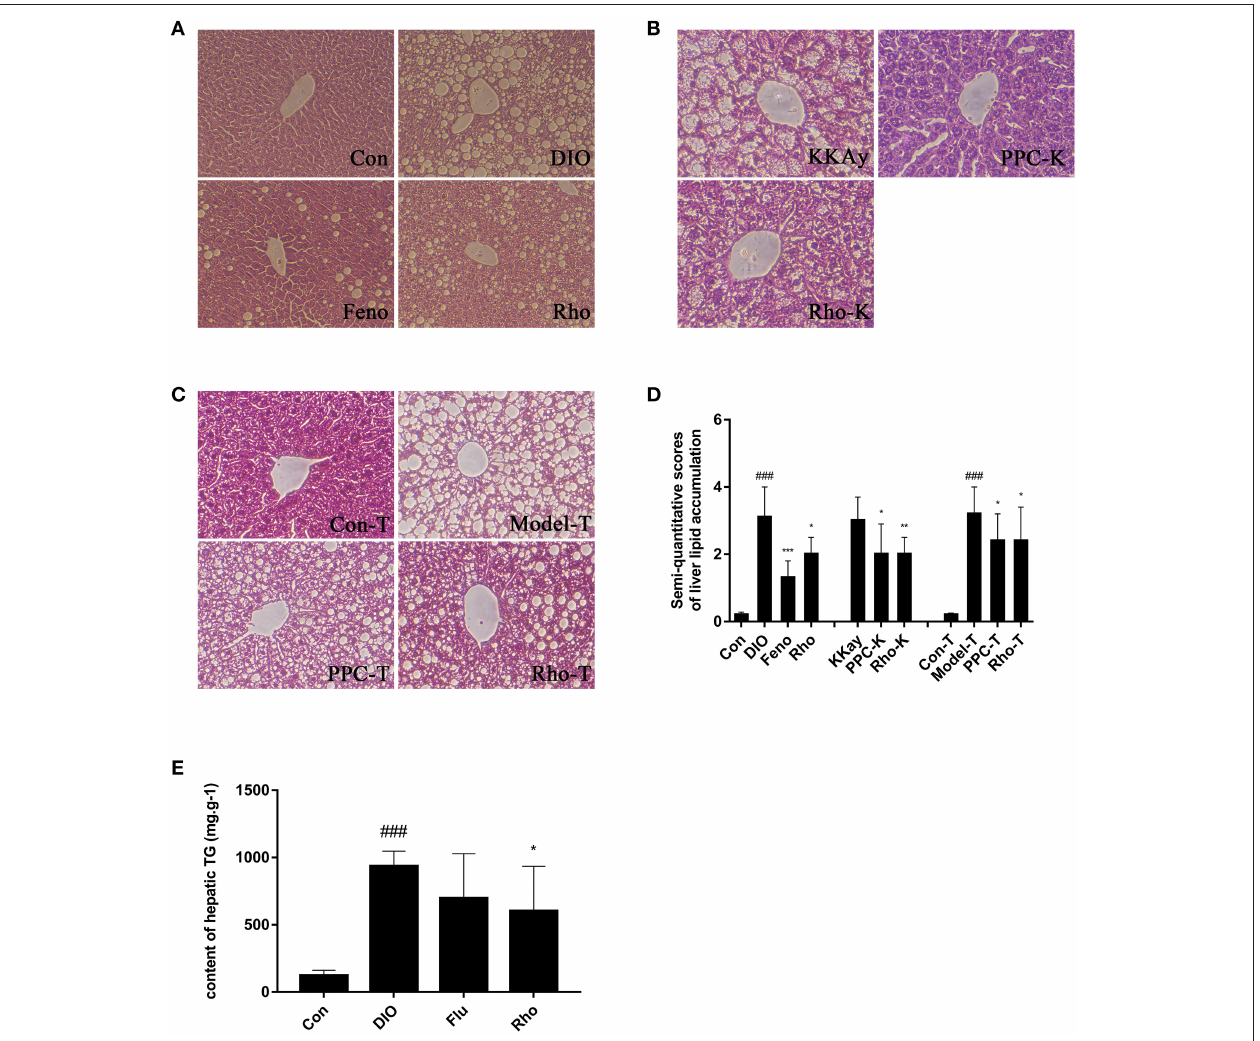
FIGURE 2 | The effect of Rho on hepatic steatosis. (A) Liver histopathological analysis in DIO mice. (B) Liver histopathological analysis in KKAy mice. (C) Liver histopathological analysis in high-fat diet combined with tetracycline-induced Model-T mice. (H&E stained) (D) Semiquantitative scoring of steatosis. (E) Hepatic triglyceride content. ### p < 0.001 vs. normal control group; * p < 0.05, ** p < 0.01, *** p < 0.001, vs. model control group, respectively, n =